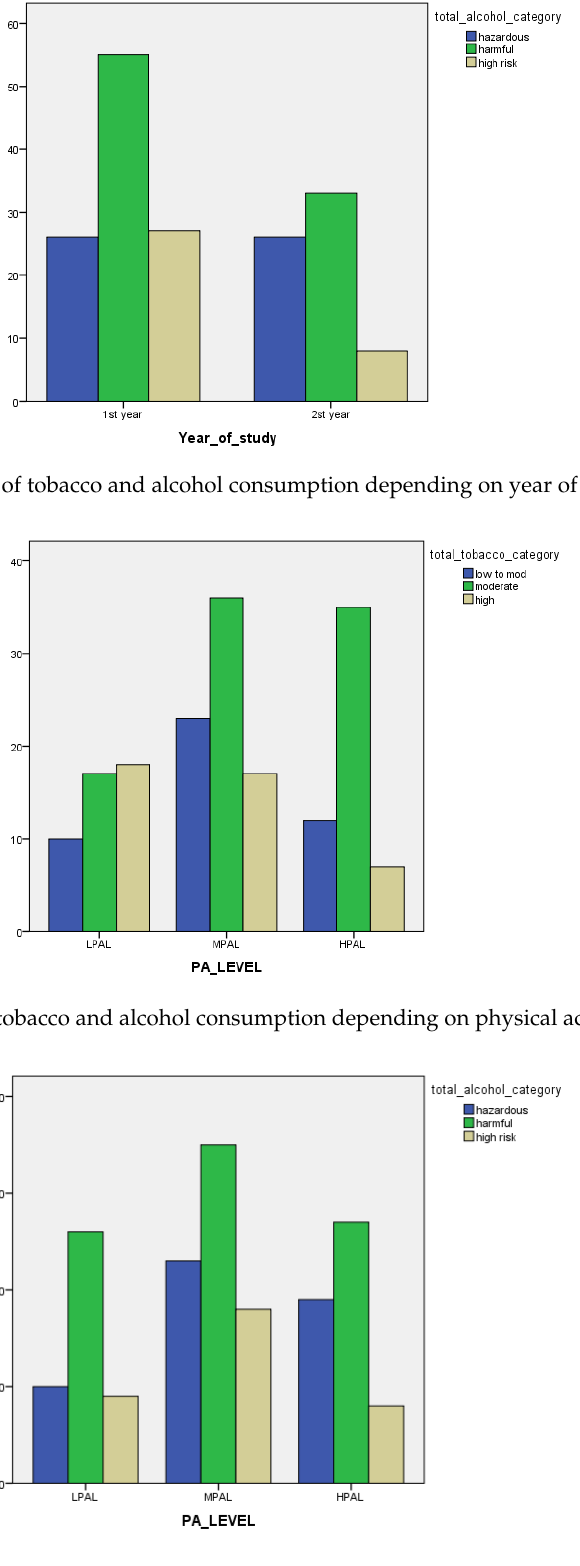
Figure 8. Frequency of tobacco and alcohol consumption depending on physical activity level (female).